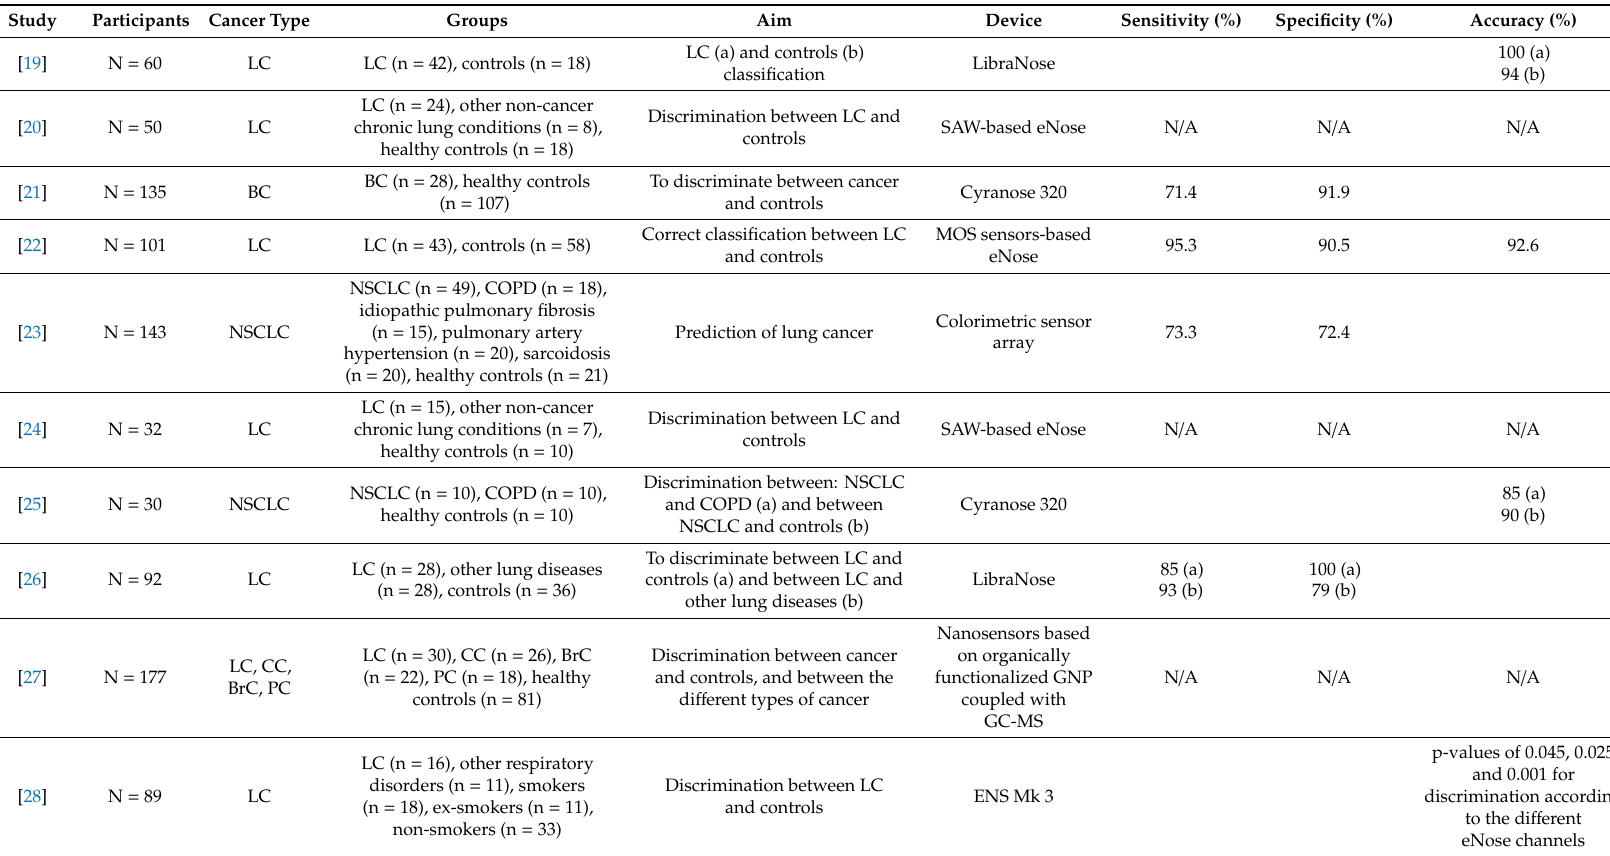
Table 1. Studies included in the literature review (AC: adenocarcinoma, AEx: asbestos-exposed, ALC: advanced lung cancer, ARD: asbestos-related diseases, BC: bronchogenic carcinoma, BlC: bladder cancer, BrC: breast cancer, CC: colon cancer, COPD: chronic obstructive pulmonary disease, CRC: colorectal cancer, ELC: early lung cancer, GC: gastric carcinoma, GC-MS: gas chromatography–mass spectrometry, GNP: gold nanoparticles, HNC: head and neck squamous cell carcinoma,